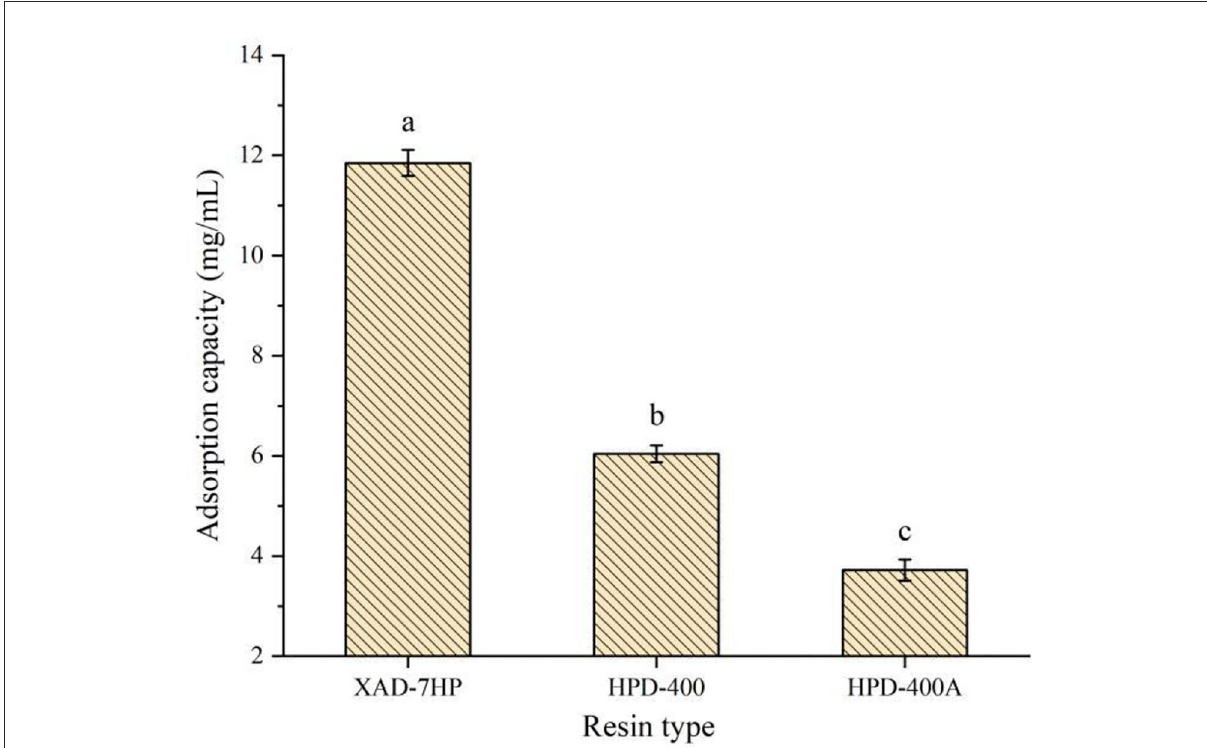
FIGURE1 Adsorption capacity of different types of resins to protein peptides of PSKB. There is a significant difference between different small letters ( P < 0.05).